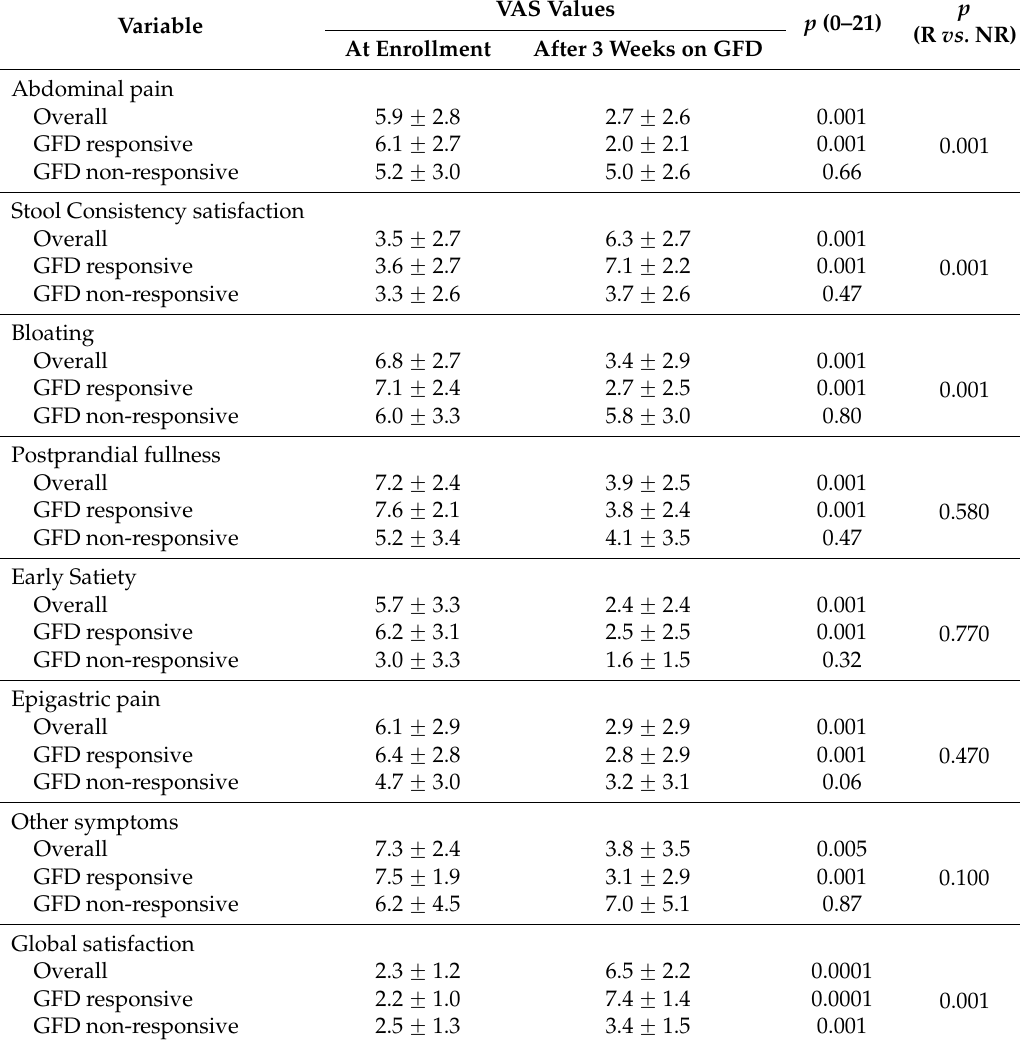
Table 2. Visual analogue scale (VAS) values of symptoms in patients responsive and non-responsive to the gluten-free diet (GFD) and in the overall series of patients. Statistical analysis was performed to evaluate the significance of the comparisons before and after the gluten-free diet (P p 0 ´ 21 q ) and between the responsive and non-responsive groups (P (R vs. NR) ) at the end of the gluten-free diet. VAS Values p Variable